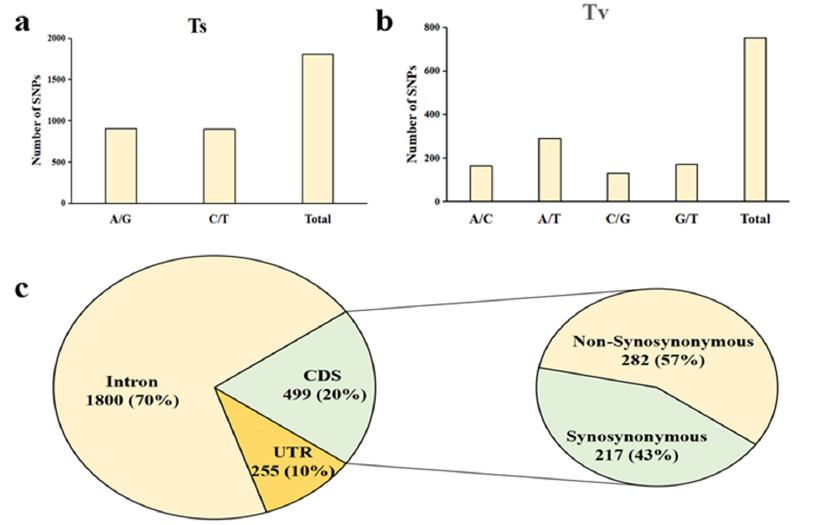
Figure 1. Classification and annotation of SNPs identified in genes related to nitrogen uptake, assimilation, and allocation. ( a ) Frequency of transitions in the SNPs, ( b ) frequency of transversions in the SNPs, ( c ) annotation of the SNPs.